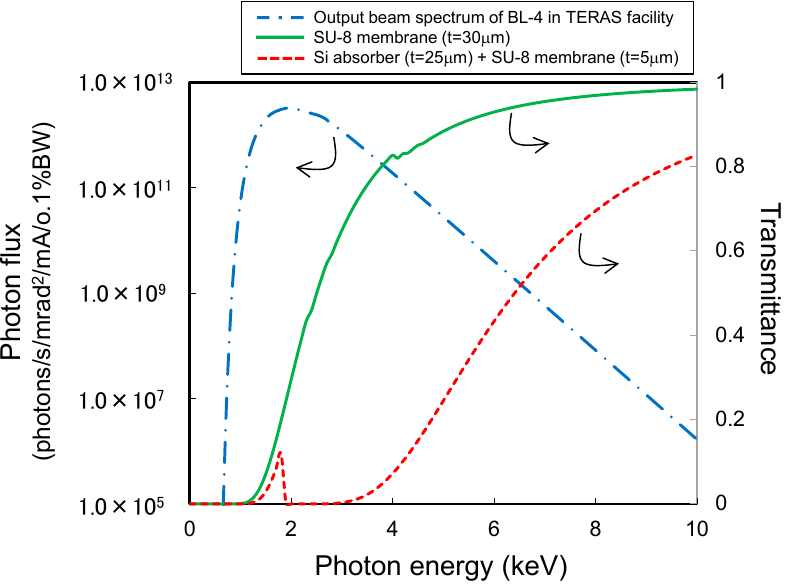
Figure 1. Calculated output beam spectrum of beamline BL-4 at TERAS synchrotron radiation facility and transmittance of SU-8 membrane (30 μ m thickness) and Si (25 μ m thickness) absorber on SU-8 film (5 μ m thickness) depended on photon energy. “t” in graph legend in the figure means